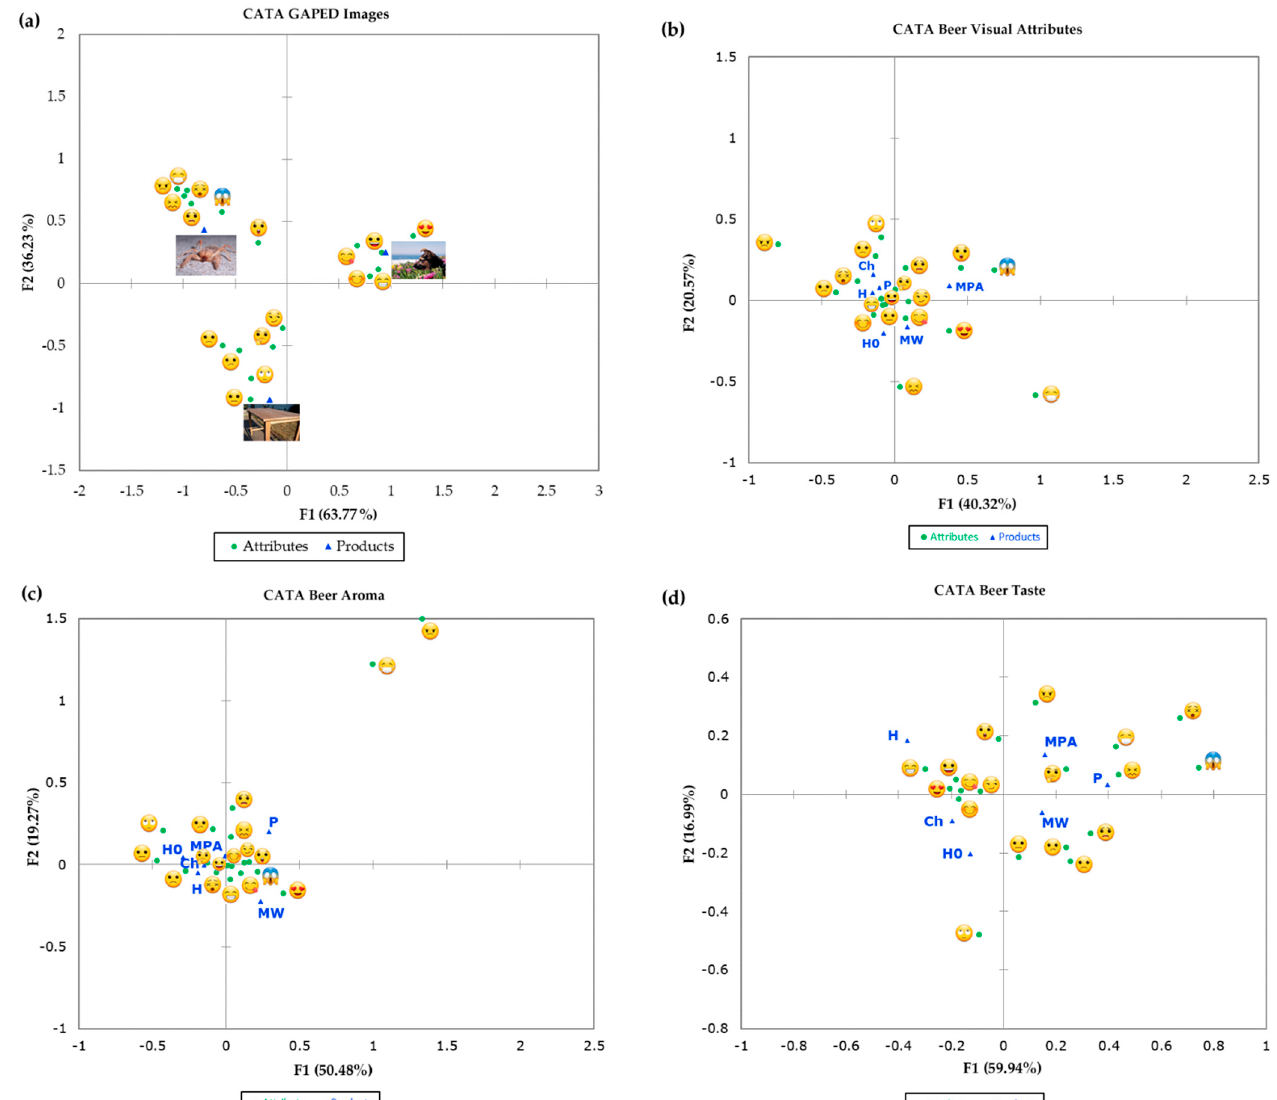
Figure 3. Correspondence analysis using the check-all-that-apply (CATA) with emojis from ( a ) the Geneva Affective Picture Database (GAPED) images, ( b ) visual attribute, ( c ) aroma attribute, and ( d ) taste attribute evaluation of the beer samples. Abbreviations of the beer samples are found in Table 1. Other abbreviations: F1 and F2: factors 1 and 2.